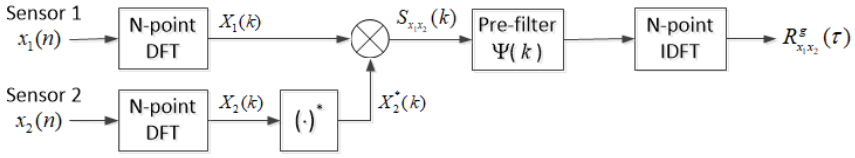
( τ ) using the generalised cross-correlation method. Figure 2. Block diagram to compute R g x 1 x 2 Table 2. Conventional prefilters for the generalised cross-correlation method